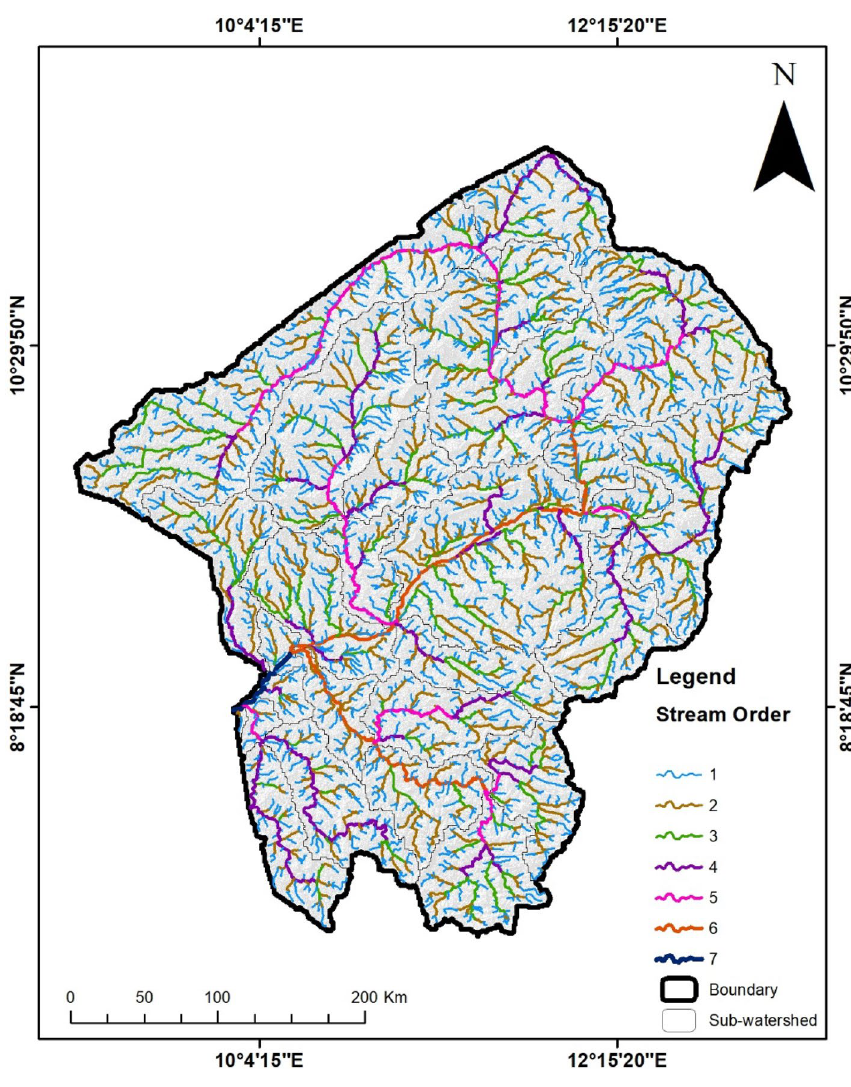
Fig. 4 Stream order of upper